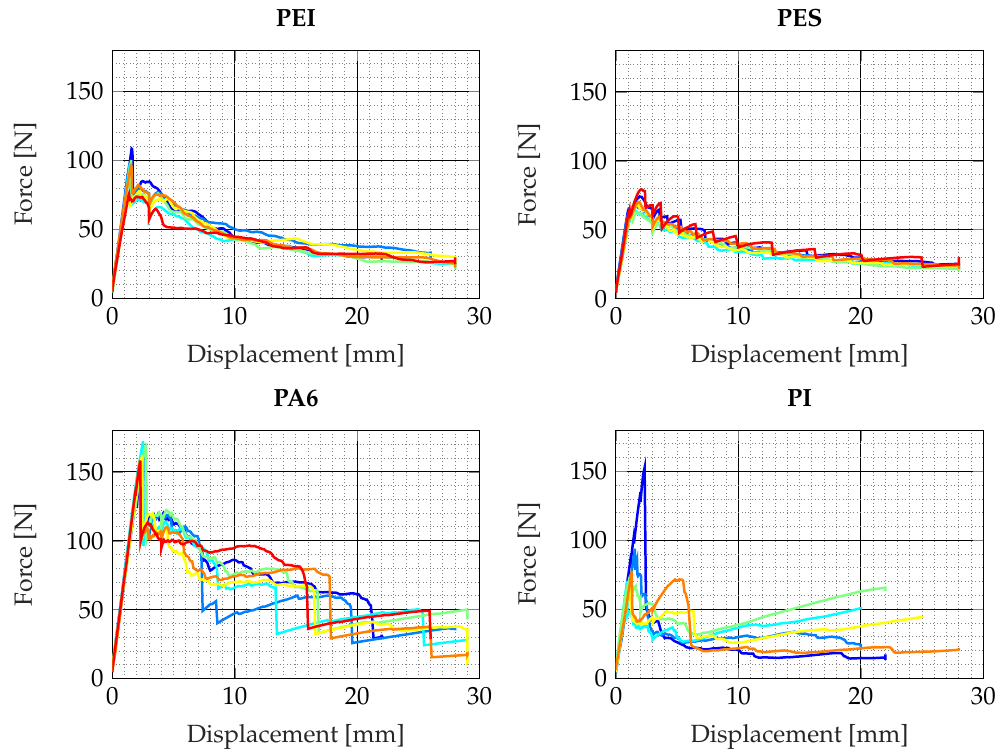
Figure 12. Force-displacement curves of laminates with different thermoplastic films in the DCB test. Every line shows the force-displacement curve of one single specimen.